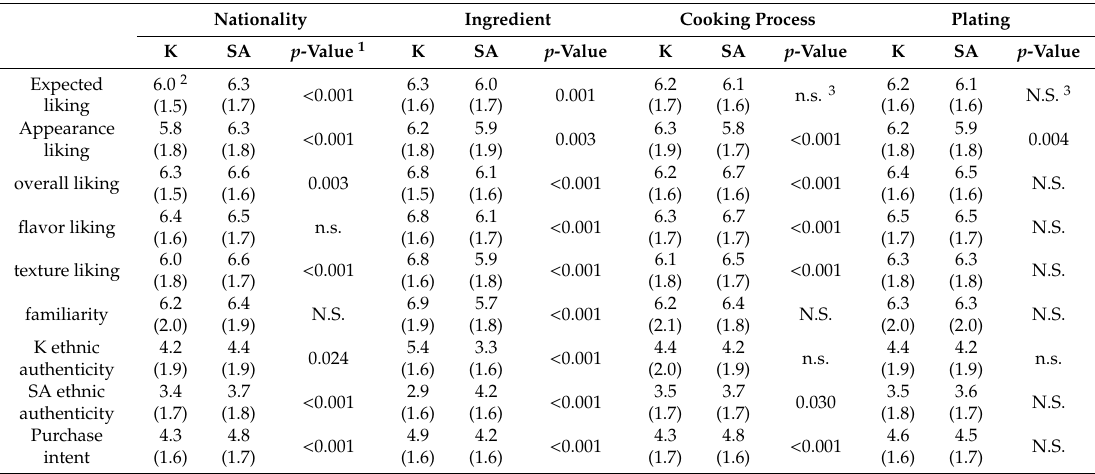
Table 4. Mean scores and p -values of hedonic ratings, familiarity, ethnic authenticity, and purchase intent according to the main factors that had significant e ff